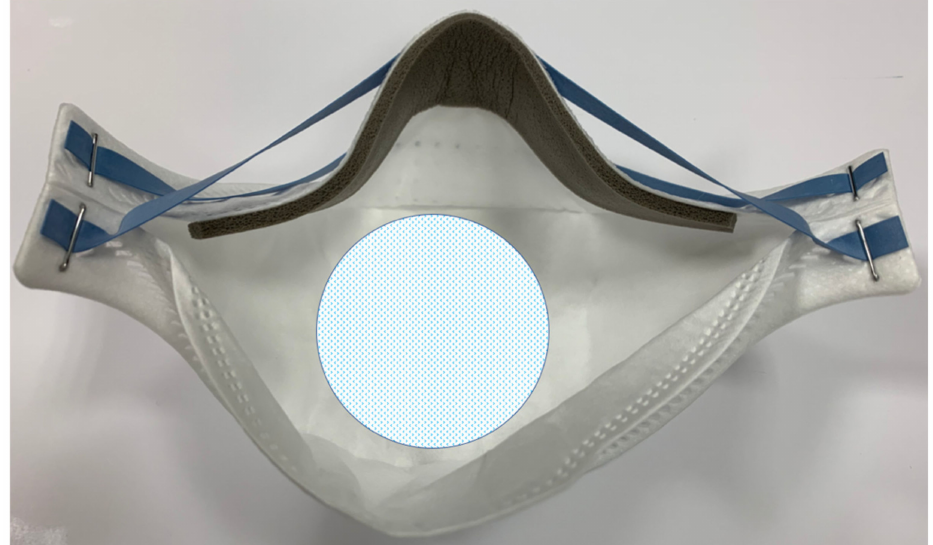
Figure 1. The central area of the internal side of the respirator where the test has been performed. The dimensions of this area are approximately 50 cm 2 and correspond to the area dimensions of the stages used in the test.